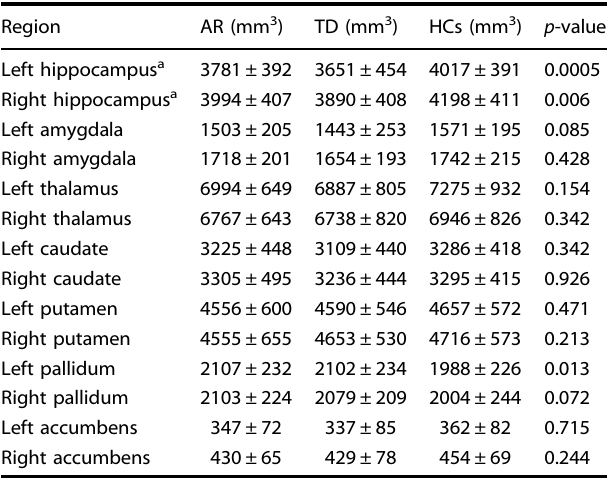
Fig. 2 Brain regions with Sulc changes in the AR and TD subtypes compared with HCs. a Brain regions showing signi fi cant Sulc change in patients with the AR subtype compared with HCs. The result was corrected for multiple comparisons using RFT. The color bar indicates the RFT-corrected p -value. b Brain regions showing signi fi cant Sulc change in patients with the TD subtype compared with HCs. The result was corrected for multiple comparisons using RFT. The color bar indicates the RFT-corrected p -value. Table 1. Volume of subcortical structures in PD patients and